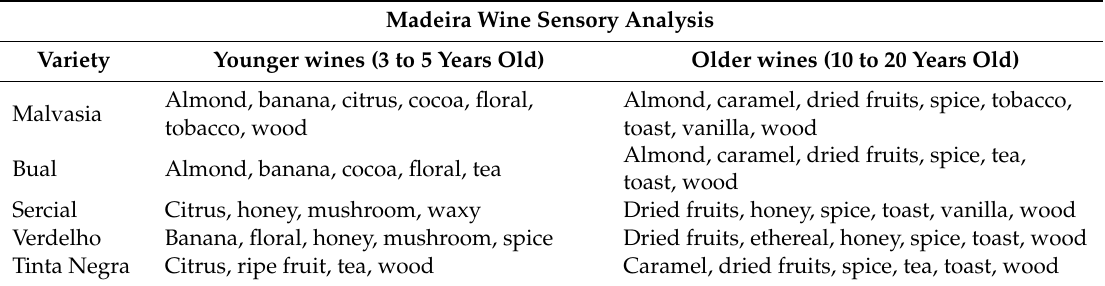
Table 2. Madeira wines sensory analysis obtained from di ff erent grape varieties, types, and